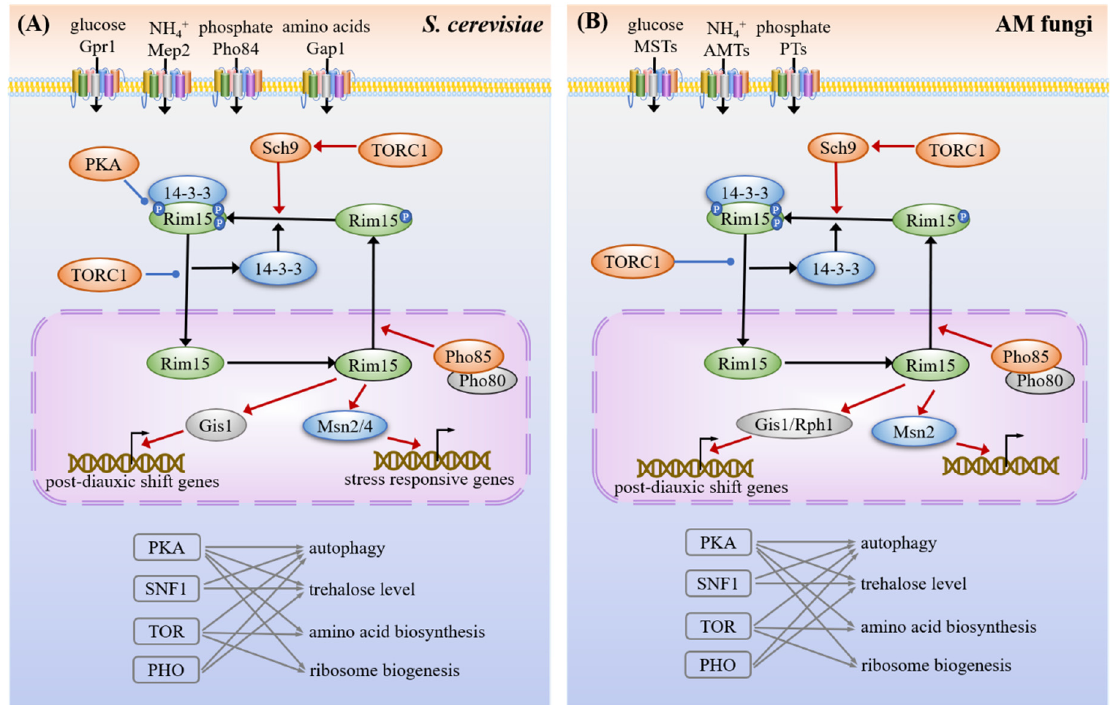
Figure 6. Common targets and crosstalk among nutrient signaling pathways in yeast ( A ) and AM fungi ( B ). The nutrient transporters acquire various nutrients from the environments and some transporters, which also act as the transceptors (transporters and receptors), transport nutrients as well as activate nutrient signaling pathways, including cAMP-PKA, TOR and PHO. All the pathways of the PKA, TORC1, Sch9 and PHO converge on the serine/threonine protein kinase Rim15. Rim15 interacts with the 14-3-3 protein to regulate Msn2/4 and Gis1 transcription factors (TFs), thereby activating the expression of the stress-responsive element (STRE) genes and post-diauxic shift (PDS) genes, respectively. The crosstalks among these pathways share a large number of common downstream targets. Msn2 and Gis1 TFs activate the transcription of the genes encoding heat shock proteins (e.g., Hsp12 , Hsp26 , Ssa3 ) upon nutrient limitation. The PKA, SNF1, TOR and PHO pathways control the expression of genes involved in autophagy (e.g., Atg8 , Atg11 , Atg13 ). The PKA, SNF1 and PHO pathways also control the expression of genes involved in the trehalose metabolism (e.g., Tps1 , Tps2 , Nth1 ), while the PKA and TOR pathways control the expression of genes involved in amino acid biosynthesis (e.g., Gcn2 , Gcn4 ) and ribosome biogenesis (e.g., Fhl1 , Maf1 , Rps ). The yeasts have both Msn2 and Msn4, while it seems that only Msn2 is present in the genomes of AM fungi. The red lines with the arrows indicate facilitation, whereas the blue lines with the dots indicate inhibition and the black arrows represent translocation.